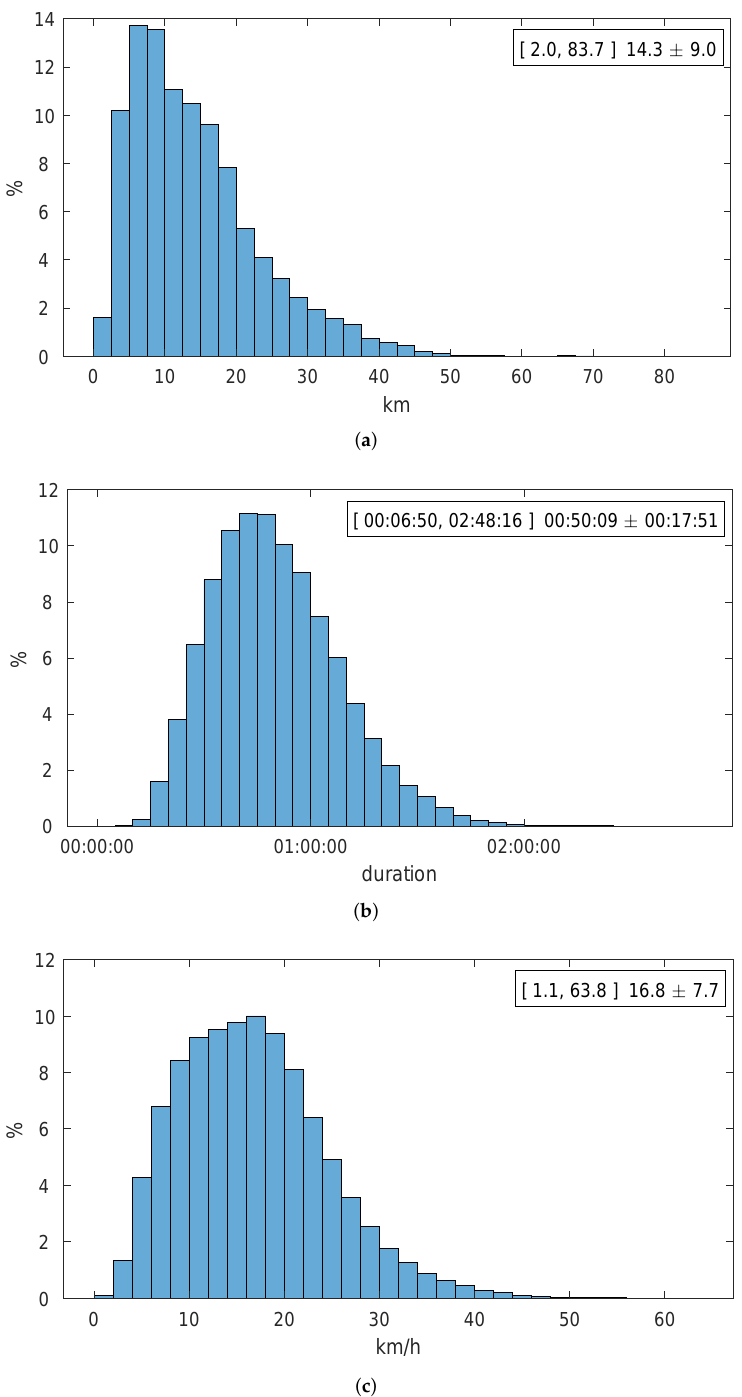
Figure 2. Statistical characterization for journeys (23 November 2018): ( a ) distance. ( b ) duration. ( c )